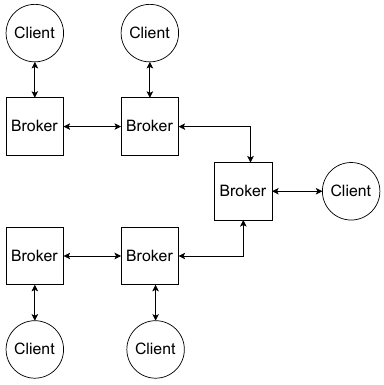
Figure 2. Illustration of fully peer-to-peer architectures.